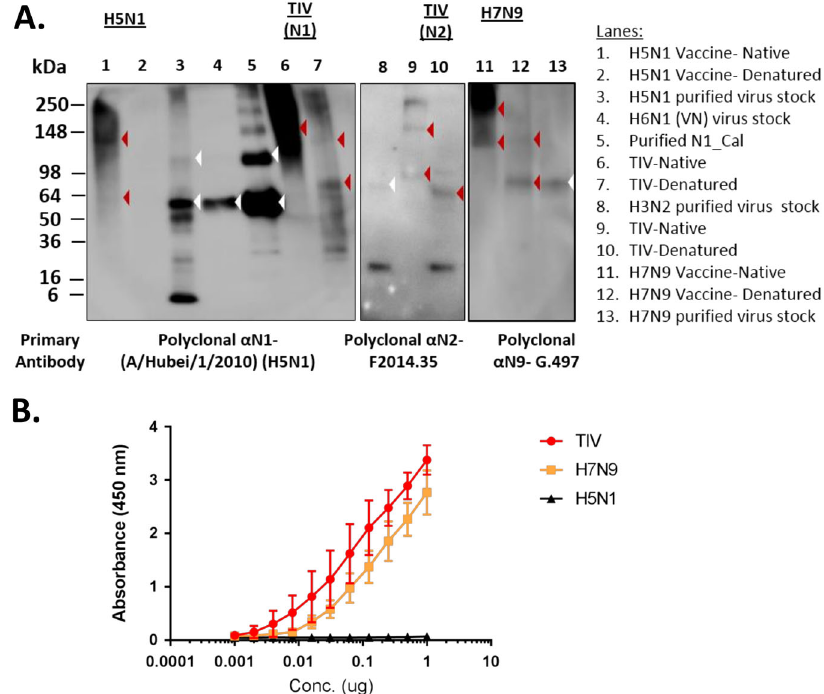
Fig. 4 Neuraminidase (NA) contents in the H5N1, TIV and H7N9 vaccines. a Western blots of vaccine preparations. Native (N) and denatured (D) vaccine preparations were probed with polyclonal serum raised against the speci fi ed NA subtype. Arrowheads indicate the expected size of NA in the vaccines ( red ) and controls ( white ). The N1-controls (lane 3,4,5) used were a concentrated and puri fi ed reverse-genetics (rg) reassortant virus containing A/Viet Nam/1203/2004 (H5N1) HA and NA, the reassortant H6N1 (A/Viet Nam/1203/2004, NA) used in the ELLA assay, and a puri fi ed N1 protein without the ectodomain derived from A/California/04/2009 (H1N1). 16 The N2-control used was a concentrated and puri fi ed A/Brisbane/10/2007 (H3N2) virus and the N9-control used was a concentrated and puri fi ed rg-reassortant virus containing A/ Anhui/1/2013 (H7N9) HA and NA. Blots were overexposed to capture faint NA-bands in the H5N1 vaccine. Samples in lanes 1 – 7, 8 – 10 and 11 – 13 were processed under the same conditions respectively and run as three separate blots. No quantitative comparison is made amongst the blots. b Neuraminidase activity in TIV, H7N9 and H5N1 vaccines as detected by enzyme-linked-lectin assay